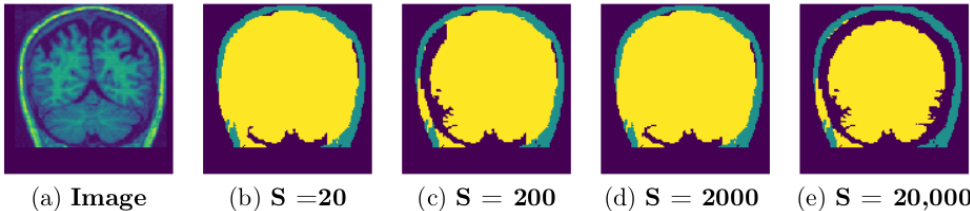
Figure 15. A representative coronal section from 3D MRI showing the separation of components for different sample size: MRI from a single subject (IBSR data set) experimented using threshold T = 0.27 and different size of the sampled nodes. GUBS is run on 3D and for visualization we take 2D at the same location for all experiments.